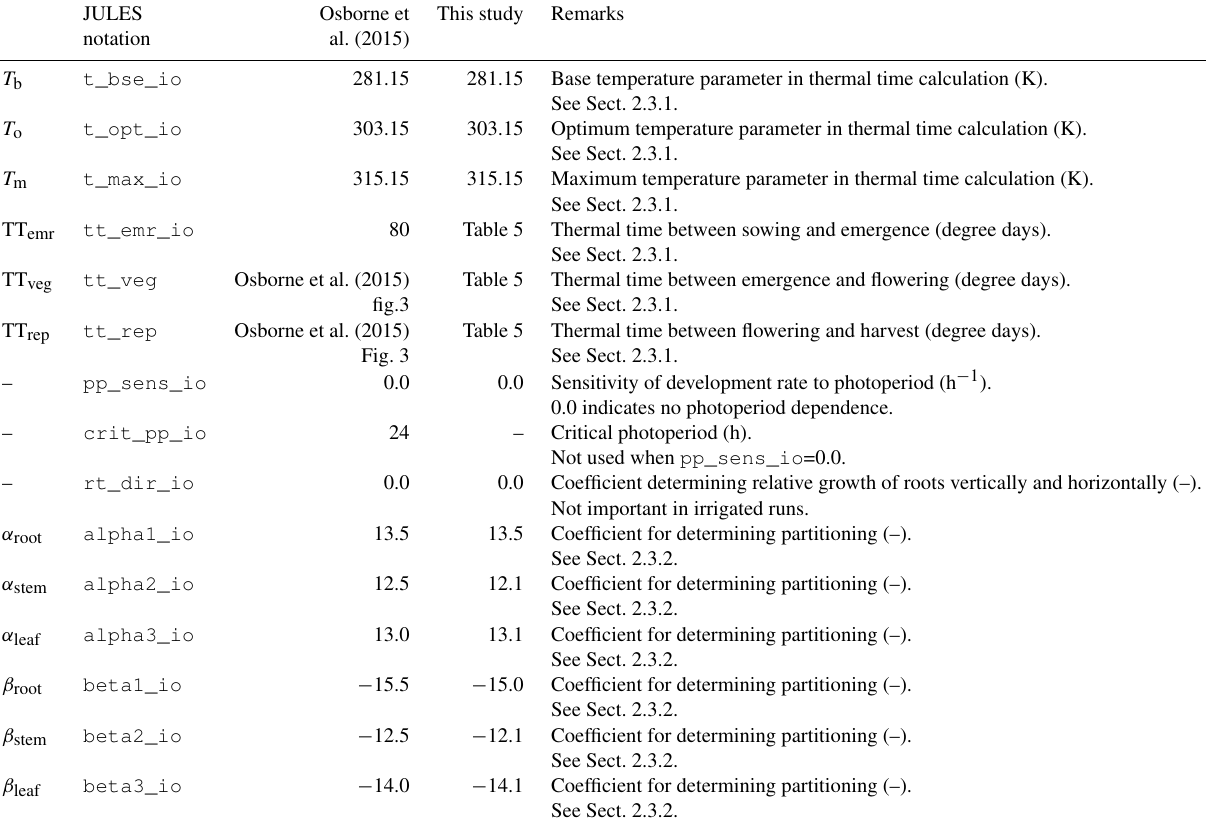
Table 3. Values of the crop-specific JULES parameters used to represent maize. Units are given in brackets; (–) denotes dimensionless. These parameters are all specified in the JULES_CROPPARM namelist.